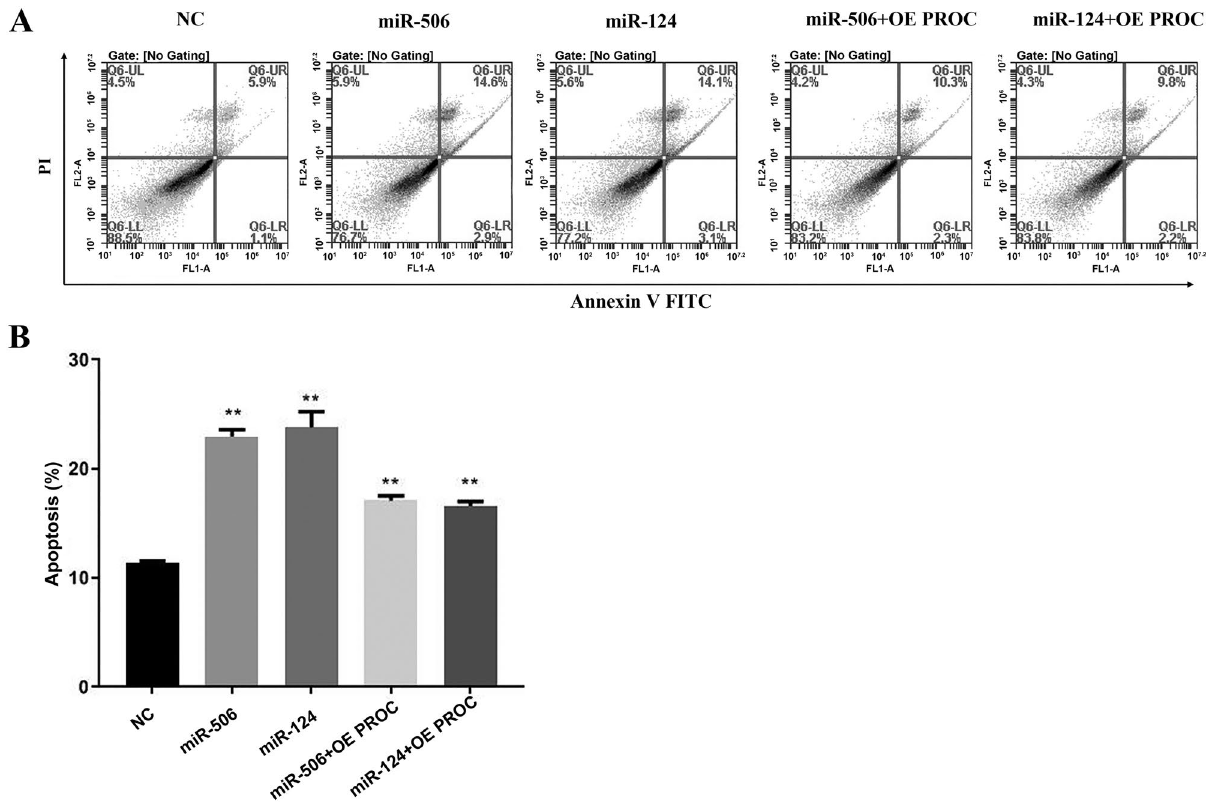
Figure 5. Role of PROC on miR-506 and miR-124-induced apoptosis of LX-2 cells. ( A ) Flow diagram of apoptosis of LX-2 cells transfected with miR-506 and miR-124 mimics alone, or with overexpressed PROC and their negative control miRNA. ( B ) The rate of apoptotic cells among different groups. OE overexpression. **Represents P <